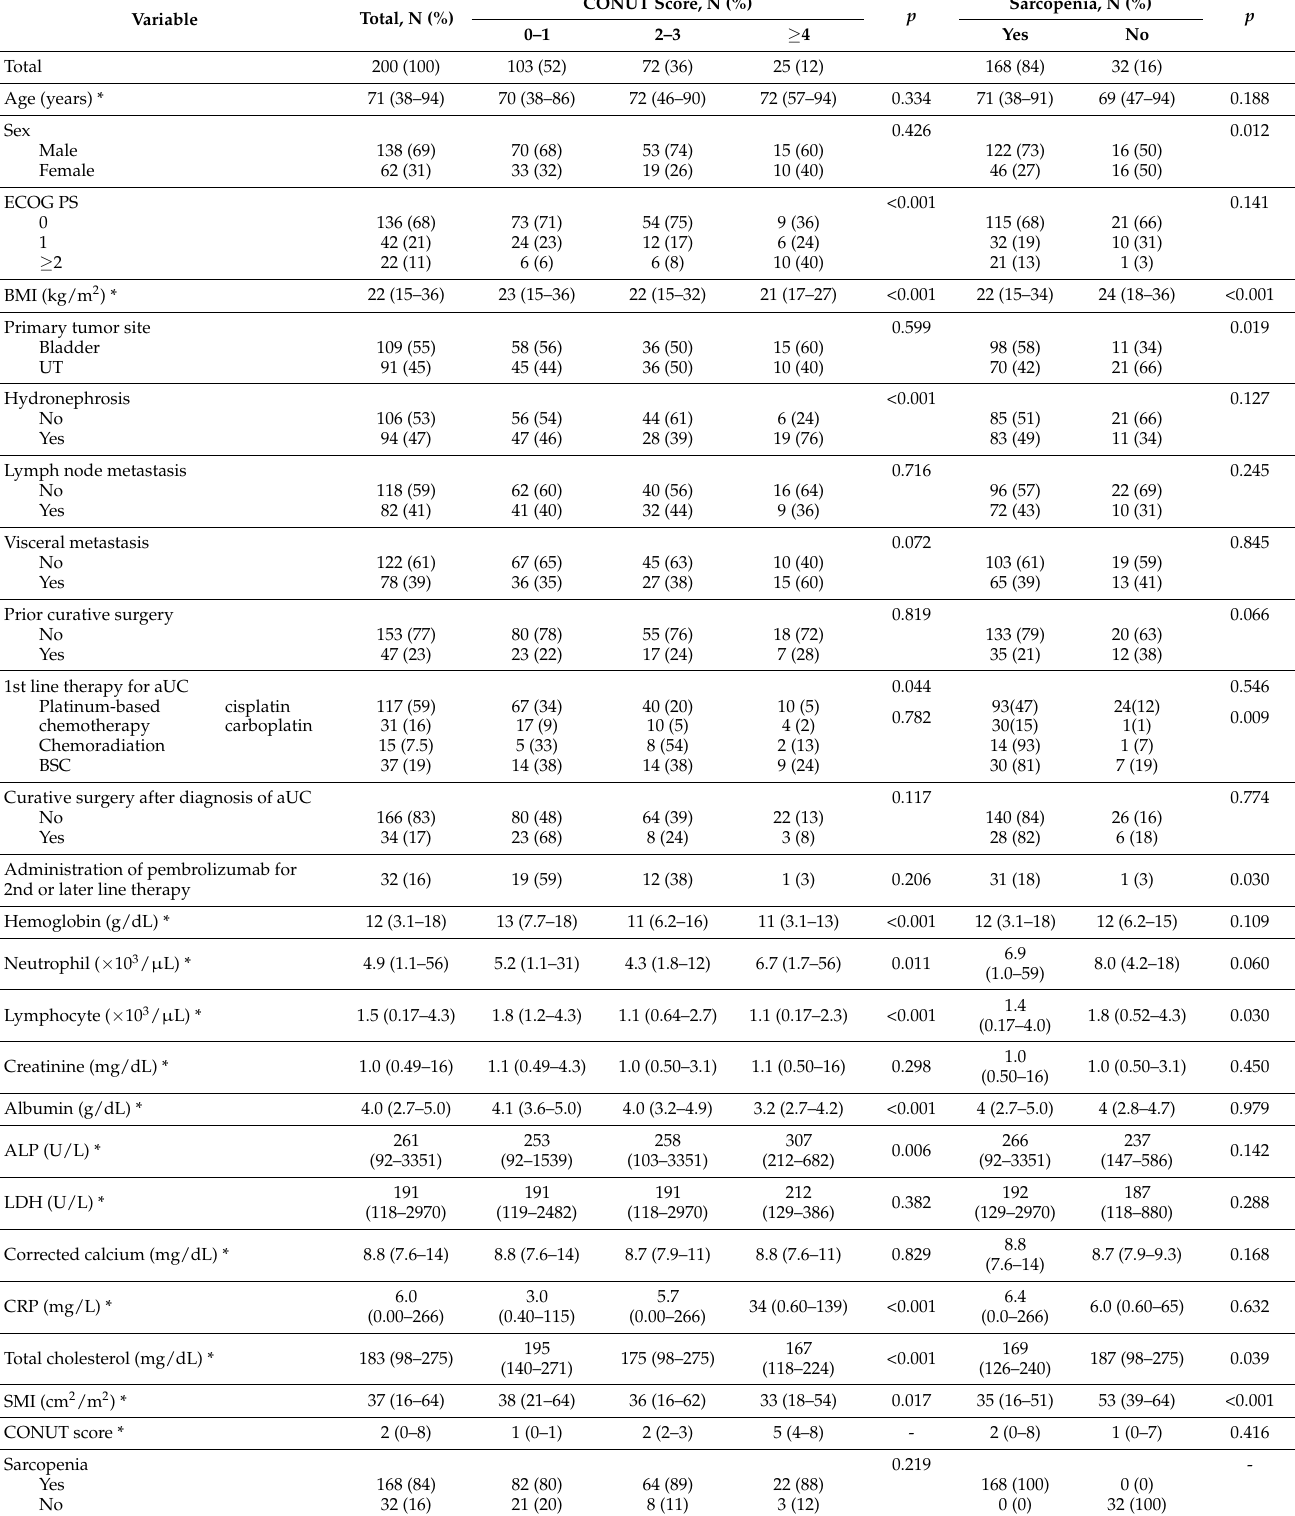
Table 2. Baseline characteristics of 200 patients with advanced urothelial